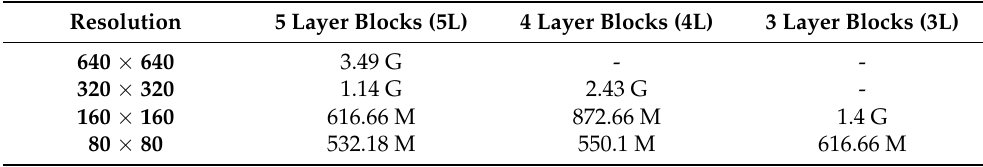
Table 1. Number of MAC operations for each individual architecture